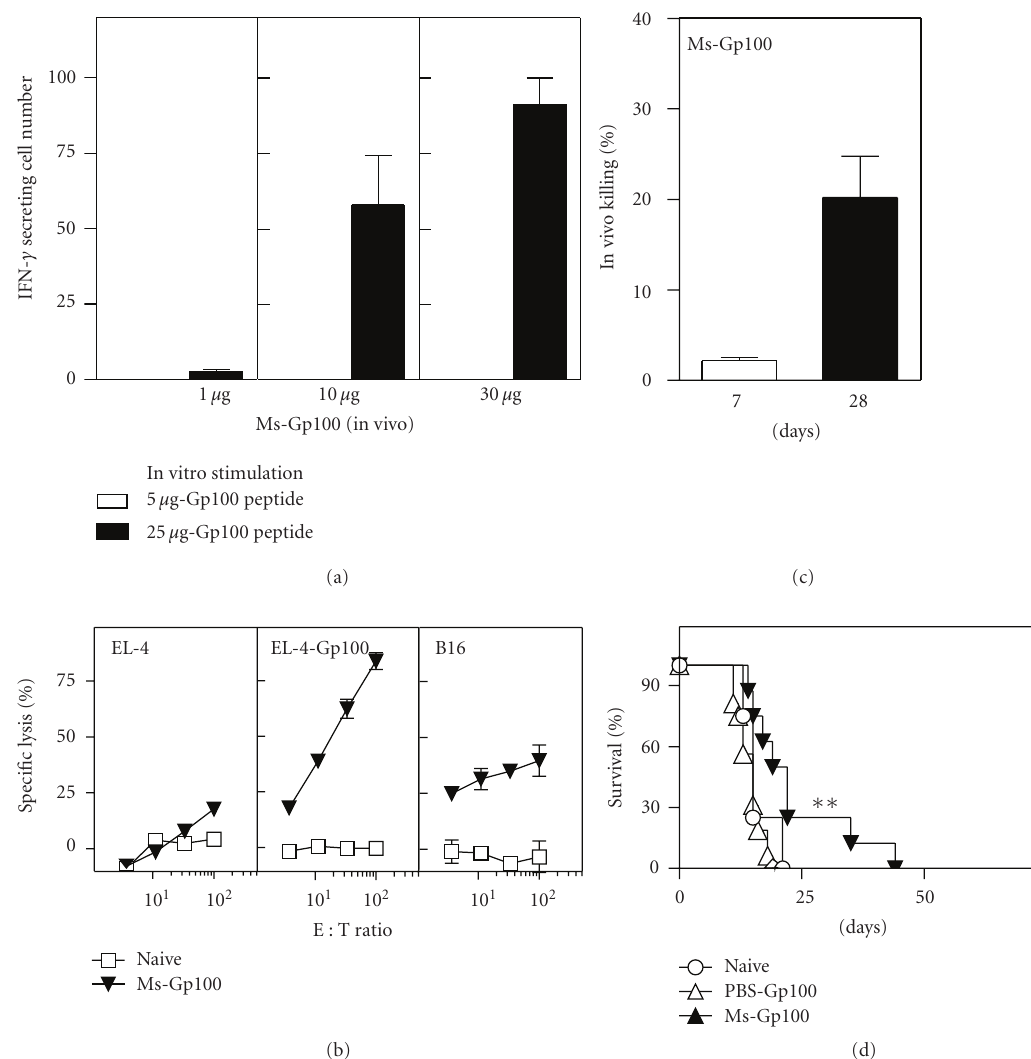
Figure 4: CD8 + T cell response and tumor protection induced by Ms-Gp100 vaccine. Mice were immunized with 1, 10, or 30 μ g Gp100 peptide entrapped in Ms archaeosomes at days 0 and 21. At 5 weeks, representative mice ( n = 2 per group) were euthanized, the spleen cells were stimulated with IL-2 (0.1ng/mL) and peptide (25 μ g/ml) for 48 h and the frequency of IFN-gamma secreting cells was enumerated by ELISPOT. Mean ± SD ( n = 3) of IFN-gamma secreting cells per 10 6 spleen cells is indicated. (a) At 5 weeks, in vitro CTL assay was also carried out on spleen cells of representative mice ( n = 2 per group) immunized with 10 μ g Ms-Gp100 (b). Mean Killing ± SD of 2 mice per group at di ff erent e ff ector: target ratio is indicated (b). In another group of representative mice vaccinated with 20 μ g Ms-Gp100, in vivo CTL response was evaluated on day 7 and day 28. Mean ± SD of n = 4 mice per group is indicated (c). Finally, response to subcutaneous B16 tumor challenge was evaluated at 6 weeks in groups of na¨ıve ( n = 12), Ms-Gp100 vaccinated ( n = 12), and PBS-Gp100 ( n = 4) vaccinated mice. Survival was monitored based on a maximum tumor size of 300mm 2 . Tumor survival data are presented as an aggregate from 3 di ff erent experiments conducted, and Gp100 peptide vaccination dose ranged from 25 to 30 μ g/injection. Loading was 112 μ g peptide/mg archaeosomes and average size 94.3 nm. Survival for Ms-Gp100 group is significantly di ff erent ( P < . 05) from na¨ıve mice by log-rank